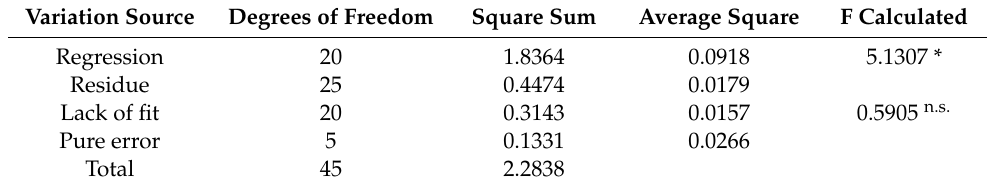
Table 3. Analysis of variance from the complete model of regression for the e ffi ciency of TMP degradation by the Fenton-like process.